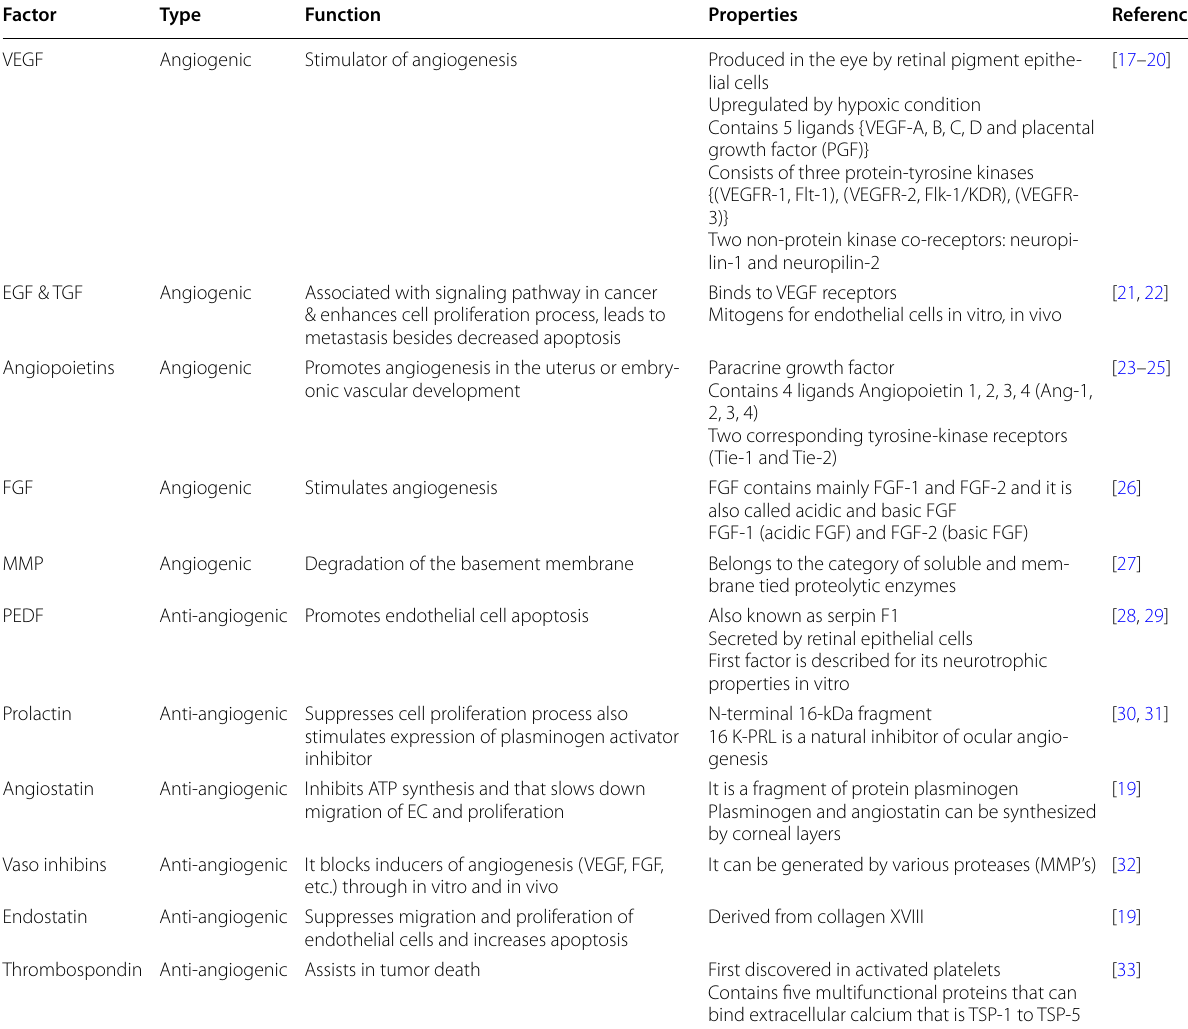
Table 1 Pro-angiogenic and anti-angiogenic factors involved in the angiogenesis process